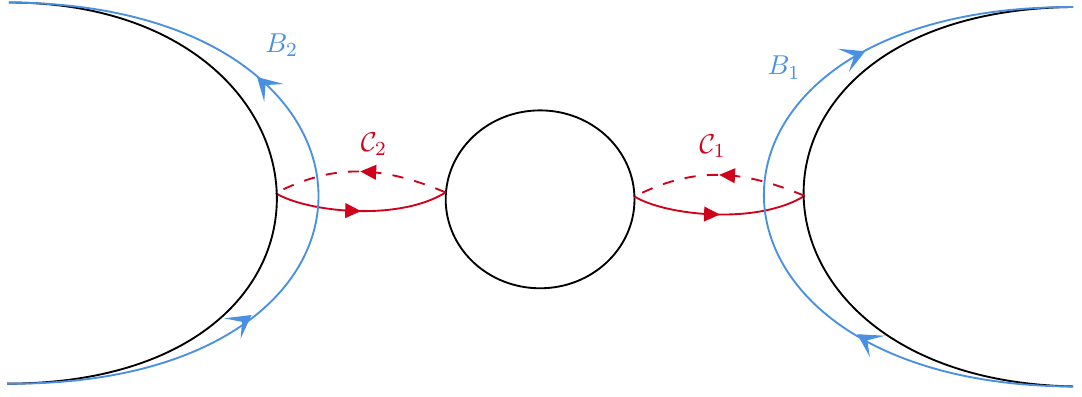
Figure 3 . The integration contours (in exponentiated coordinates) used in the derivation of the genus-zero free energy. Note that we no longer have the 2 πi periodicity of the Riemann sheets because we are in exponentiated